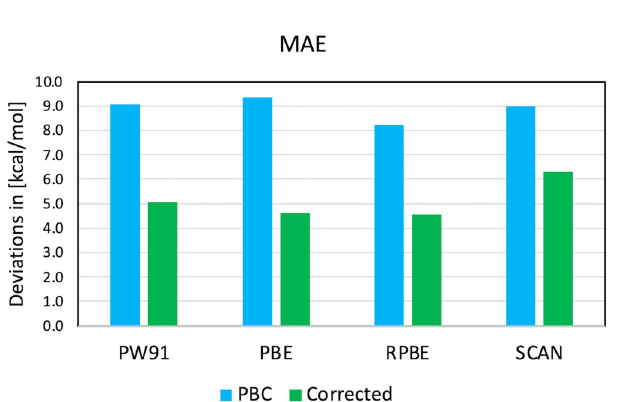
thePBE+D3/M06(orange)andthe fi nite-sizeclusterwithM06(green).Sourcedata are provided as Source data fi le.